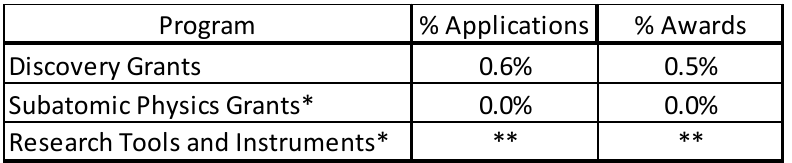
Indigenous Persons, 2020 Competition